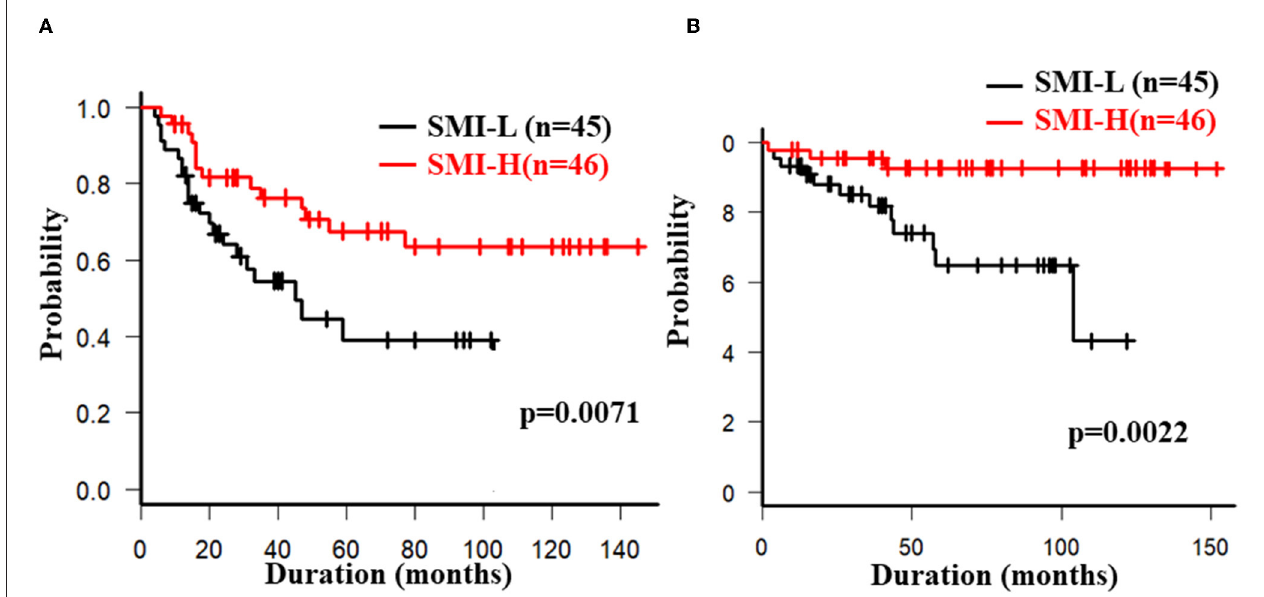
FIGURE 1 | Cumulative secondary failure-free (A) and bowel resection-free (B) rates classified according to the SMI.